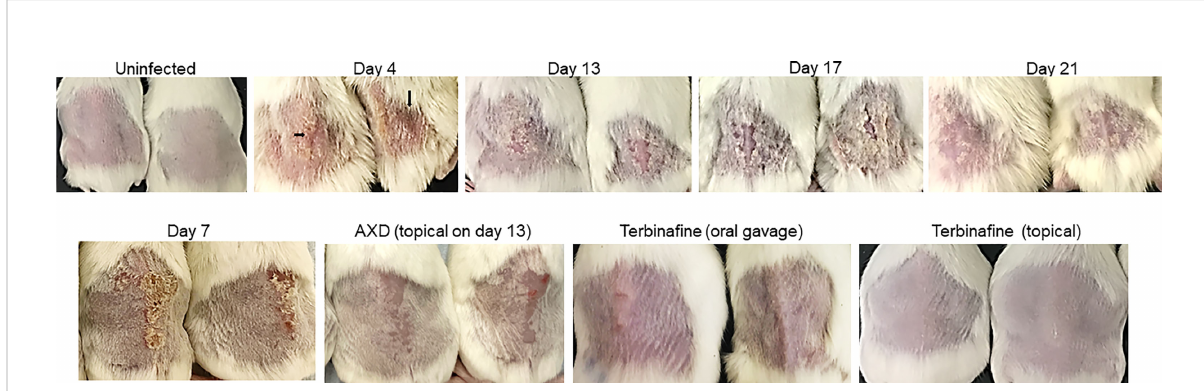
FIGURE 1 Clinical picture of dermatophytosis by T. mentagrophytes on the skin of mice and ef fi cacy of antifungal drugs: Skin of the back of diabetic mice were infected with 1 × 10 7 conidia and the clinical picture of infection was monitored over time. Arrows indicate redness and edema. Infected skin at day 7 was also treated topically with AXD (20 µg) or terbina fi ne (1% topical, or oral gavage 75 mg/kg). Observe the complete clearance of hyperkeratosis and redness post treatment with both drugs.